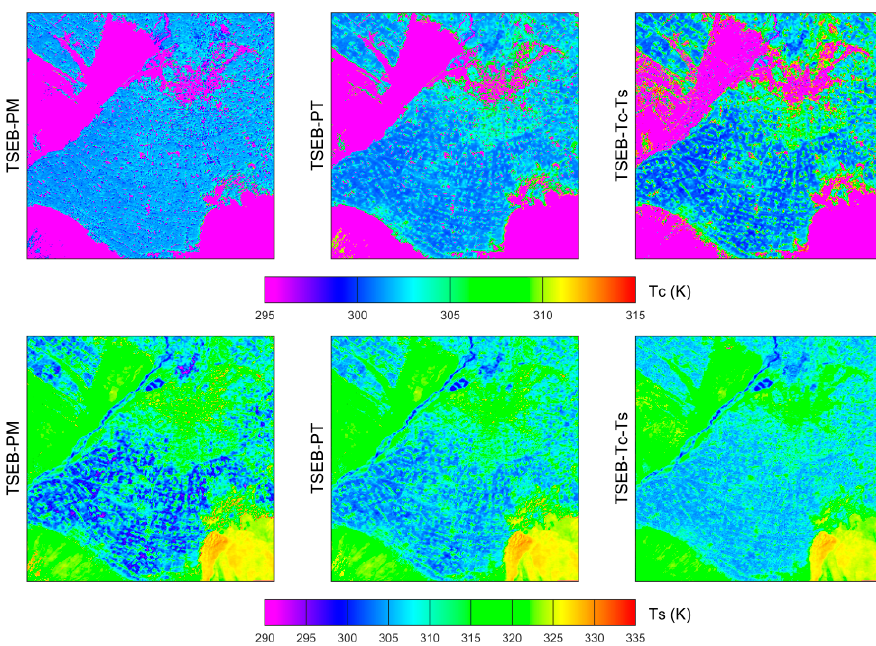
Figure 8. The spatial distribution of T C (first row) and T s (second row) over HiWATER-MUSOEXE derived from TSEB-PT, TSEB-PM, and TSEB- T C - T S on 10 July 2012.